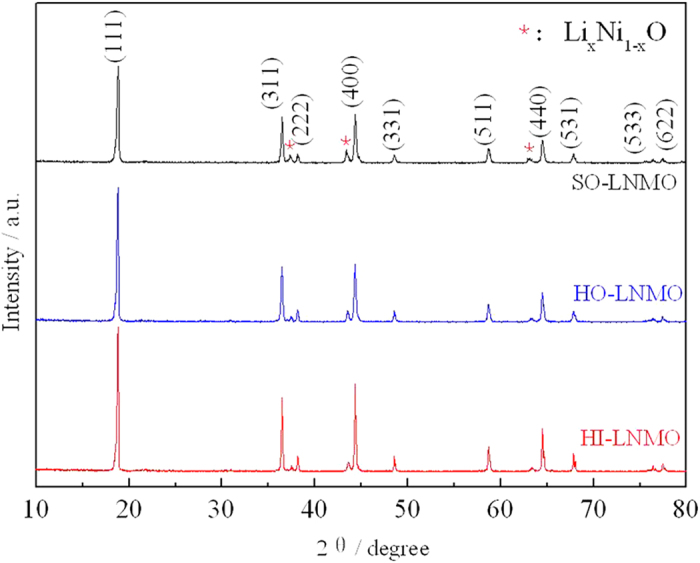
XRD patterns of LiNi0.5Mn1.5O4 with different microstructures.